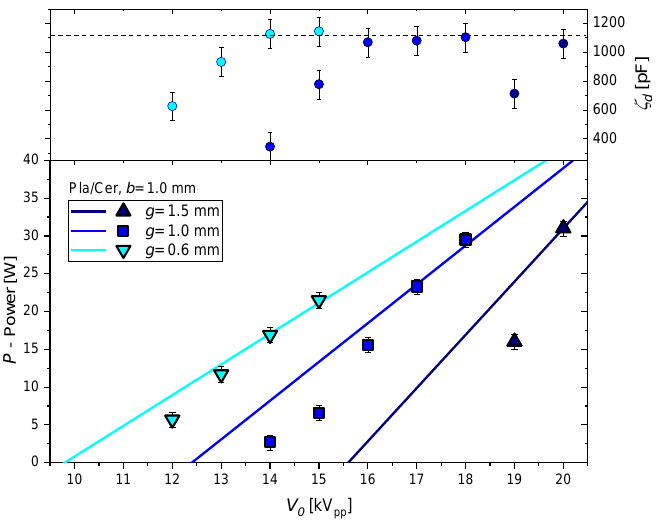
Figure 9. Effective dielectric capacitance (top) and discharge power (bottom) as function of voltage amplitude for different discharge gap width measured in pure CO 2 . The lines are calculated with the classical Manley equation ( β